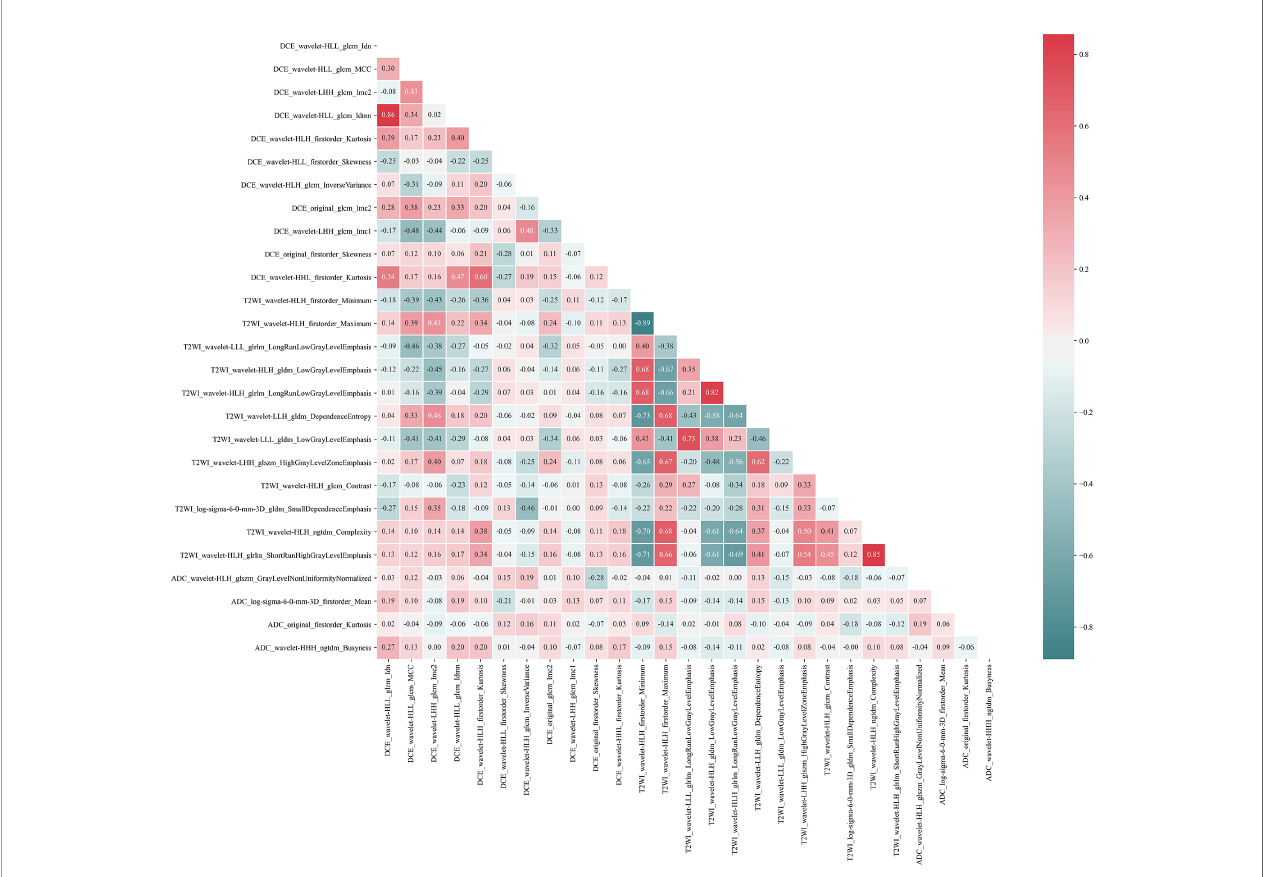
FIGURE 2 | Pearson correlation coef fi cient heatmap of selected features on predicting AR expression. Red color denotes a positive correlation, and green color denotes a negative correlation, and the shade of the color indicates the correlation